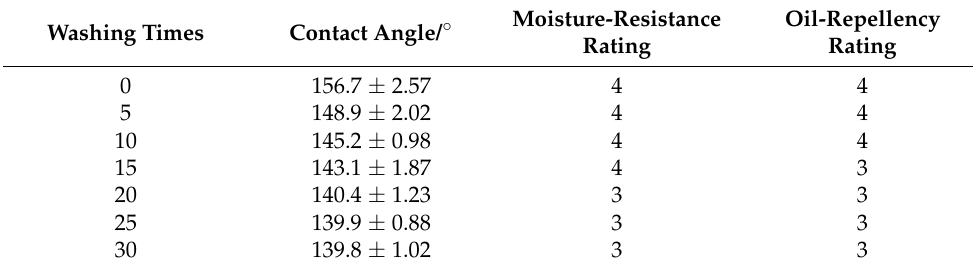
Table 3. Durability and water repellency of cotton